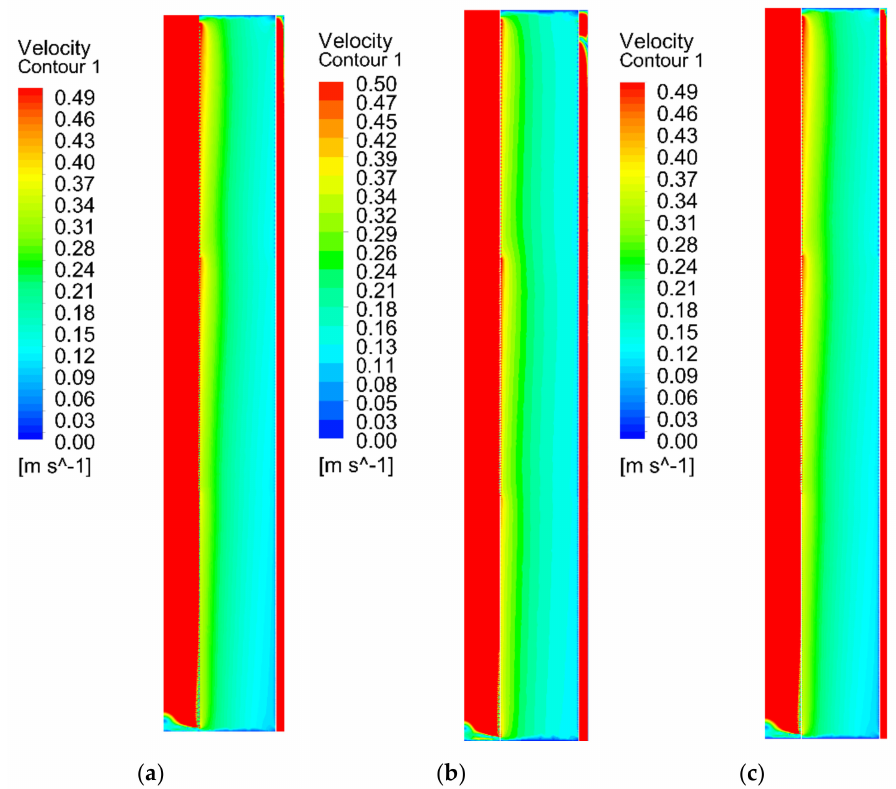
Figure 11. Velocity contour by changing the annular channel width: ( a ) Velocity contour for strategy 6; ( b ) Velocity contour for strategy 2; ( c ) Velocity contour for strategy